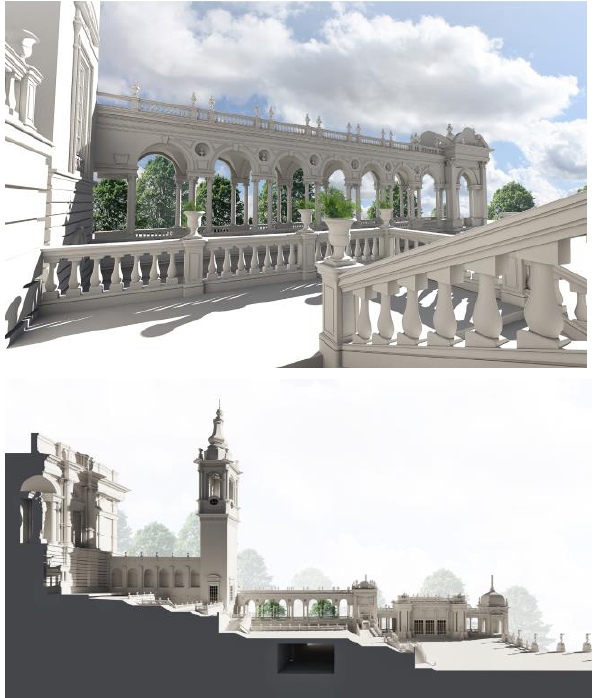
Figure 13. Realistic views of the of the Courtyard of Honour 3D model